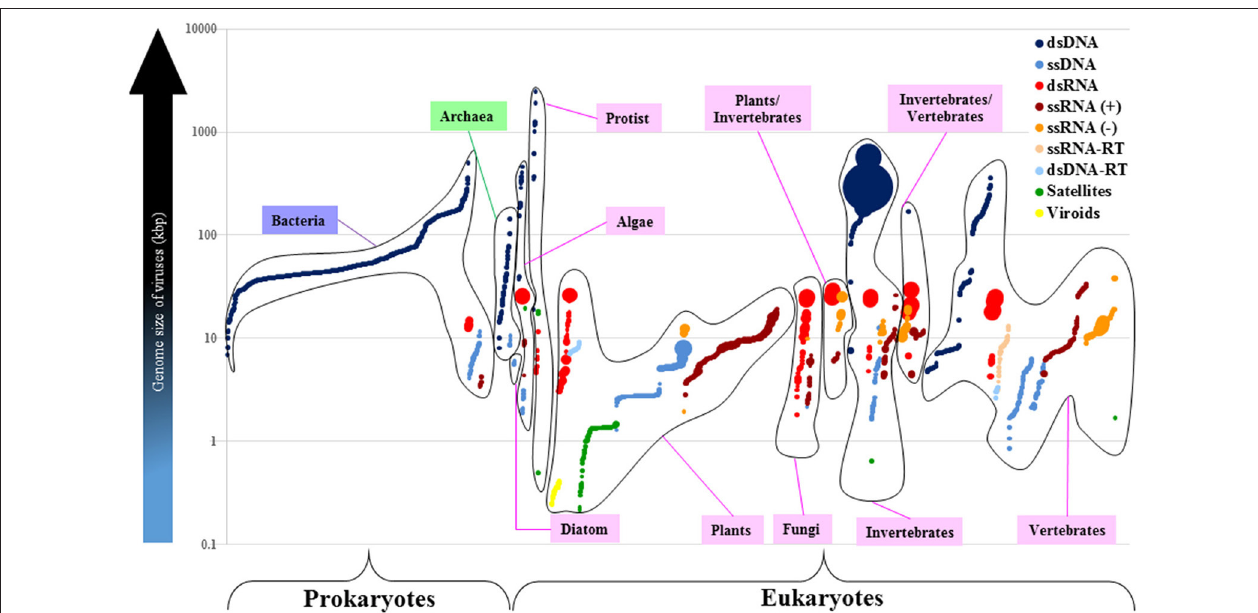
FIGURE 4 | The dsRNA viruses with larger-and-segmented genomes infect different groups of eukaryotes. Each viral group based on the Baltimore Classification is identified by a different color. Each closed-line group refers to either a prokaryote or a eukaryote host. Each circle represents one of all 4182 viral reference strains distributed in the x axis according to the host they infect (Bacteria in purple, Archaea in green, and Eucarya in pink). The volume of circles is directly proportional to the number of genome segments of each virus. The log scale shows the genome size of viruses in kilobase-pair units. There are no segmented-dsDNA genomes in viruses (only one exception: the Polydnaviridae that exceeds the 100 segments; big dark-blue circles). Genome size of RNA viruses cannot surpass the 40-kbp boundary. Most of the segmented viruses infect plants and animals (vertebrates and